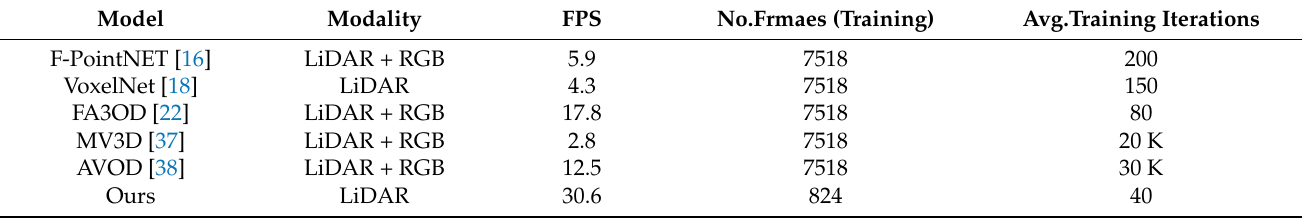
Table 2. Comparison between the existing methods and proposed method in terms of data requirements and training time.